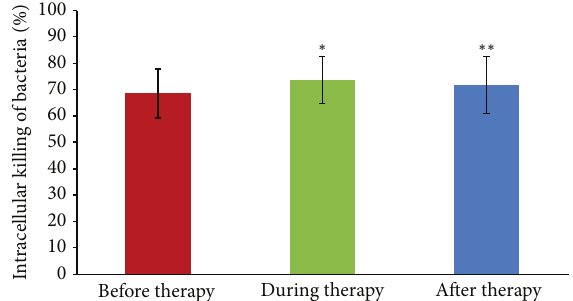
Figure 3: Mean intracellular killing of E. coli B ( ± SD) by PBMCs isolated from patients with good response to phage therapy before ( 𝑛 = 19 ), during ( 𝑛 = 17 ), and after phage therapy ( 𝑛 = 13 ). ∗ Statistically significant increase of IKB observed during EPT compared to the value at the beginning of EPT (Mann-Whitney 𝑈 test). ∗∗ Statistically significant increase of IKB observed after EPT compared to the value at the beginning of phage treatment.